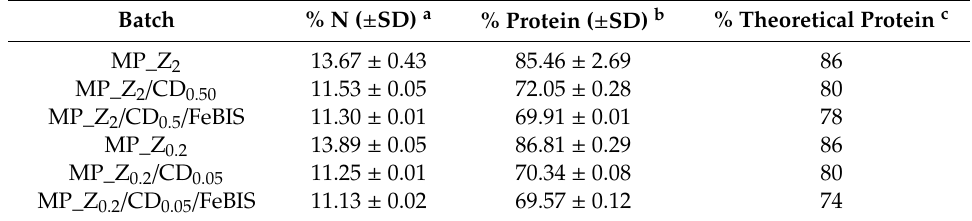
Table 1. Nitrogen and protein content of zein